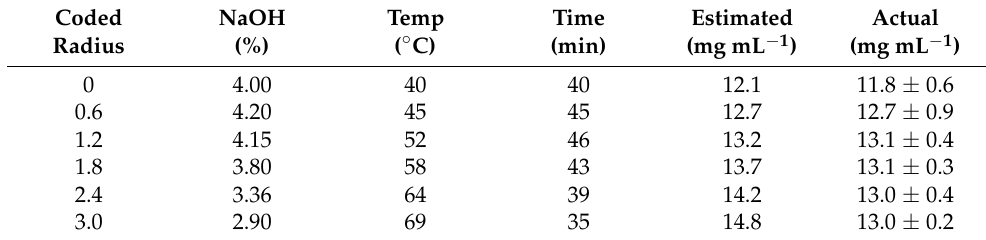
Figure 3. Response surface and contour plots show the effect of ( a ) NaOH concentration and extraction time, and ( b ) NaOH concentration and extraction temperature, on the extraction of ChS. Table 3. Ridge analysis for the extraction of